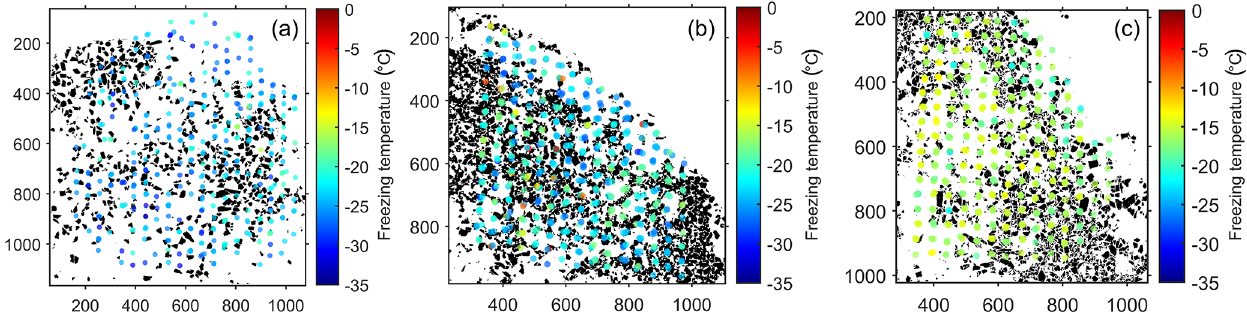
Figure 3. Binary images of grain mounts (a) FS08-01, (b) FS08-64o, and (c) FS08-64c, overlaid with the heat maps of droplet arrays color- coded according to the droplet-freezing temperatures. Heat maps for three repeated experiments are combined. The numbers on the x and y axes are pixel coordinates of the images. The pixel size is 8.8µm.